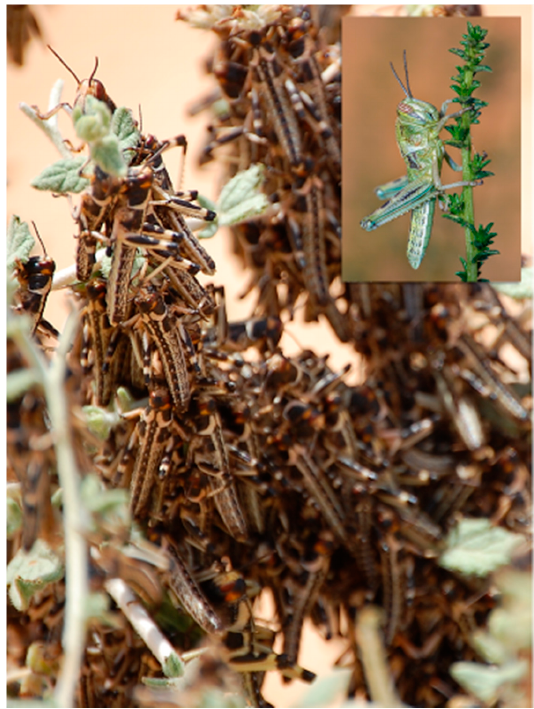
Figure 2. Locust density-dependent phase polyphenism. Gregarious locusts demonstrating extremely high density while perching on the vegetation (IV instar nymphs). Inset shows a solitary nymph. Photo credit: Amir Ayali, Gil Wizen (Inset).